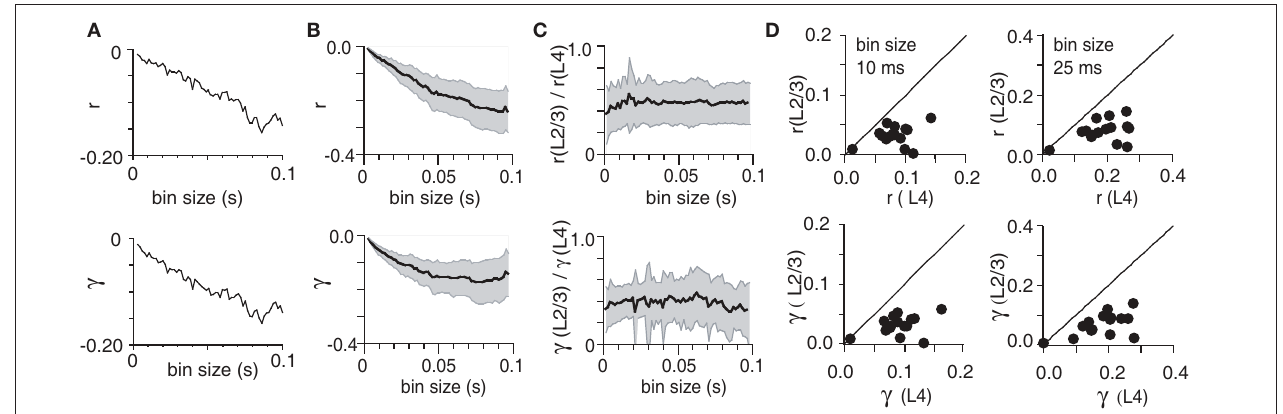
Figure 3 | Correlations decrease as spiking activity propagates from L4 to L2/3. (A) Graphs show difference in cross-correlation coefficient ( ∆ r , top) and complex coherence ( ∆γ , bottom) of L2/3 and L4, as a function of time bin size, in an example experiment. (B) The average difference in ( r ) and ( γ ) across all experiments. Shaded area denotes 95% confidence intervals. (C) Graphs shows